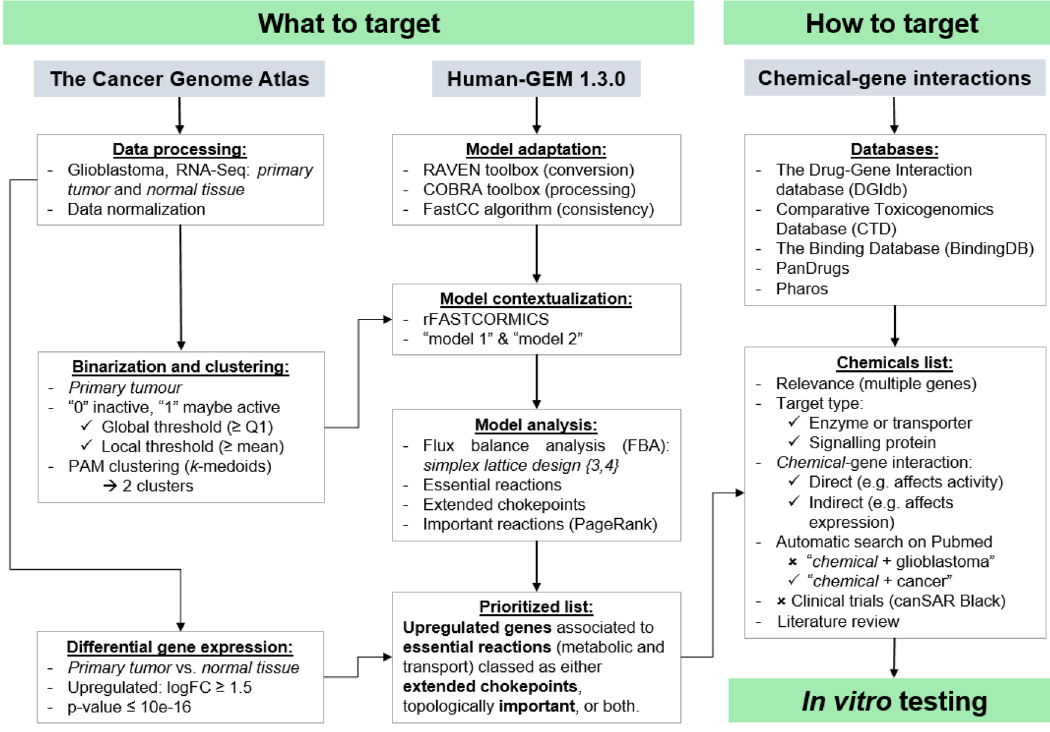
Figure 1. TISMAN (Transcriptomics-Informed Stoichiometric Modelling And Network analysis), the workflow developed in this study. It comprised three main parts (what to target, how to target and in vitro testing), where both MATLAB and R scripts were